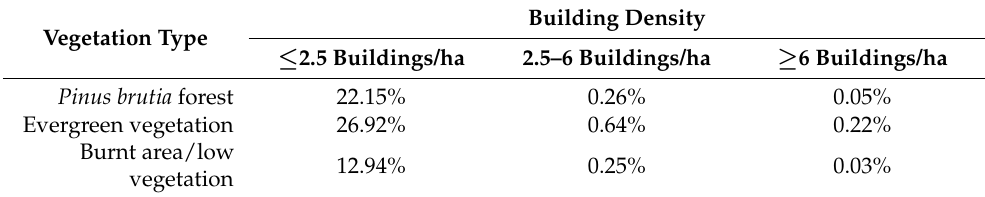
Table 2. Distribution of WUI zone (WUI category I) based on the building density and the type of forest vegetation, and the percentages of the WUI area they